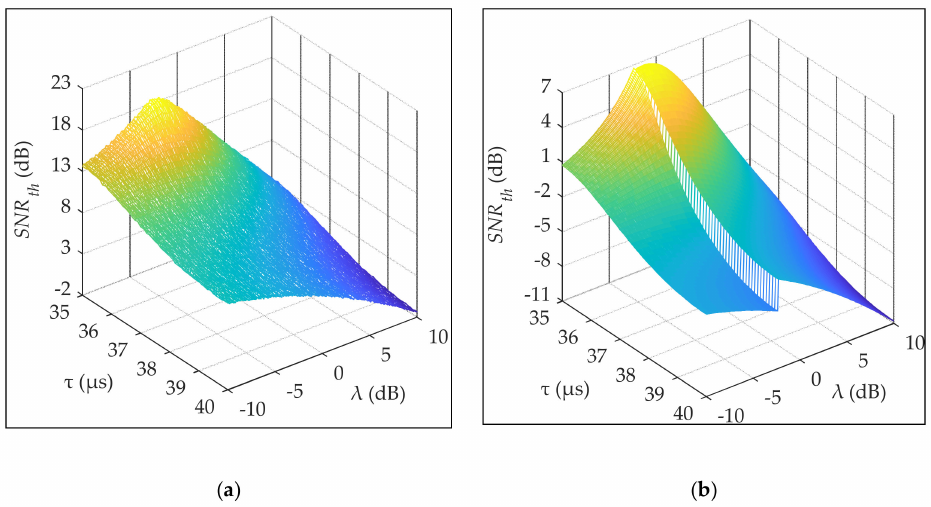
Figure 8. Demodulated SNR th as a function of τ and λ : ( a ) envelope phase detection–majority decision (EPD–MD) method; ( b ) envelope correlation–phase detection (EC–PD) method.